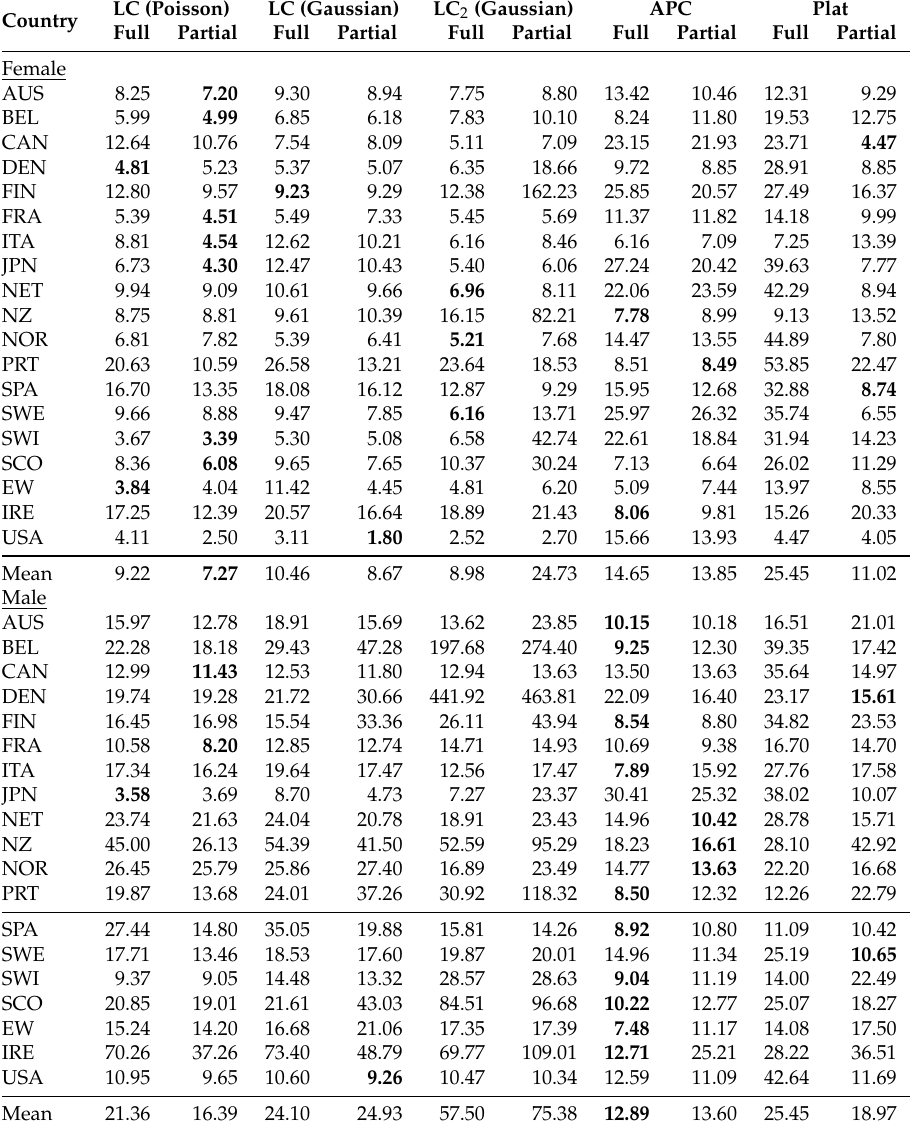
Table 5. For the 30-step-ahead forecast horizon h = 30, we compute the mean interval score ( × 100) for each country and each